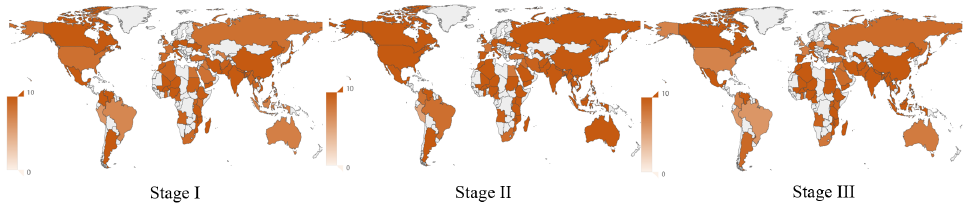
Figure 7. The sustainability score of countries in three stages.